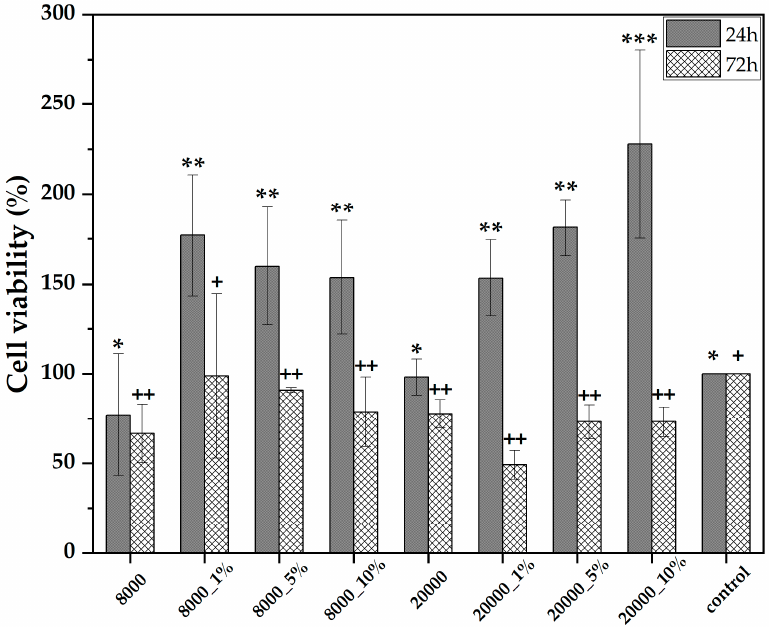
Figure 9. Cell viability results for the pristine and the RA-loaded magnetite microspheres (HepG2 cell line; values are expressed as mean ± standard deviation; different signs indicate significant differences between each sample, * and +—lower significance, **, *** and ++—higher significance).